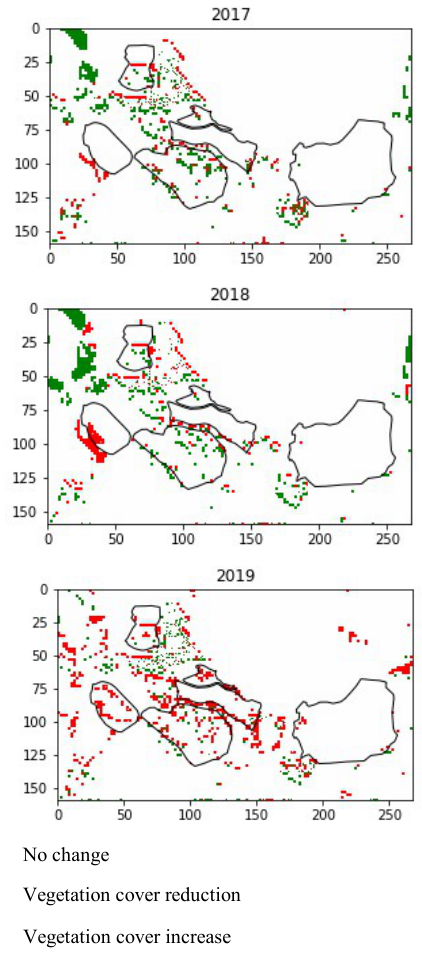
Figure 8. Change detection maps in spring. The reference year is 2016. Cover vegetation maps of years 2017, 2018 and 2019 are compared to 2016.